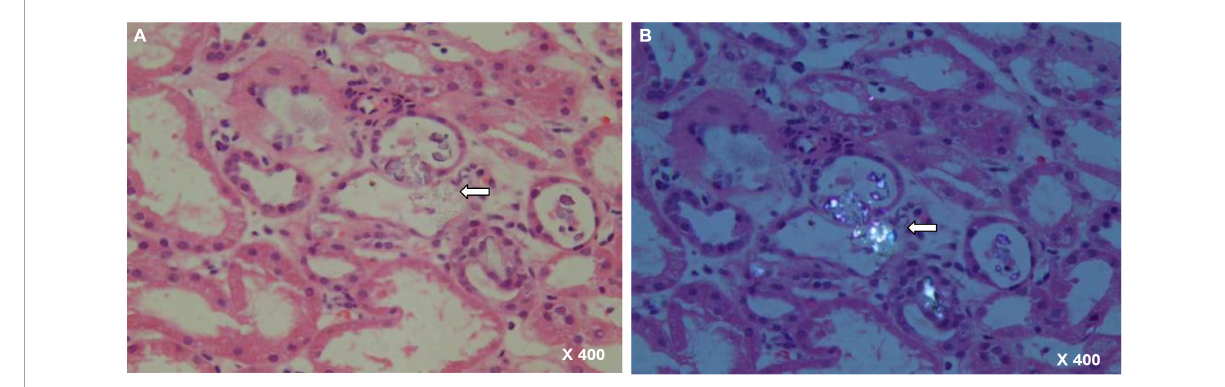
FIGURE1 Renal biopsy specimen with arrow showing a couple of calcium oxalate deposits within renal tubules. (A) HE staining, 400 × magnification. (B) Polarized light, 400 ×